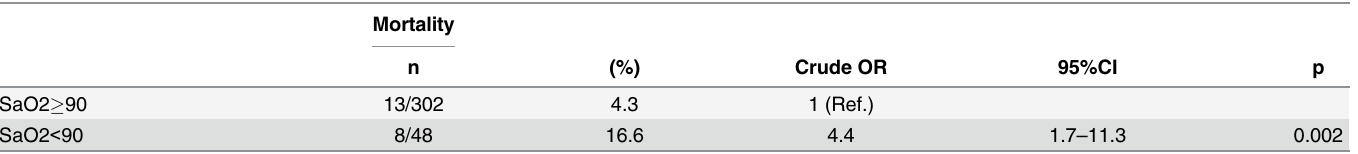
the model (Data not shown).